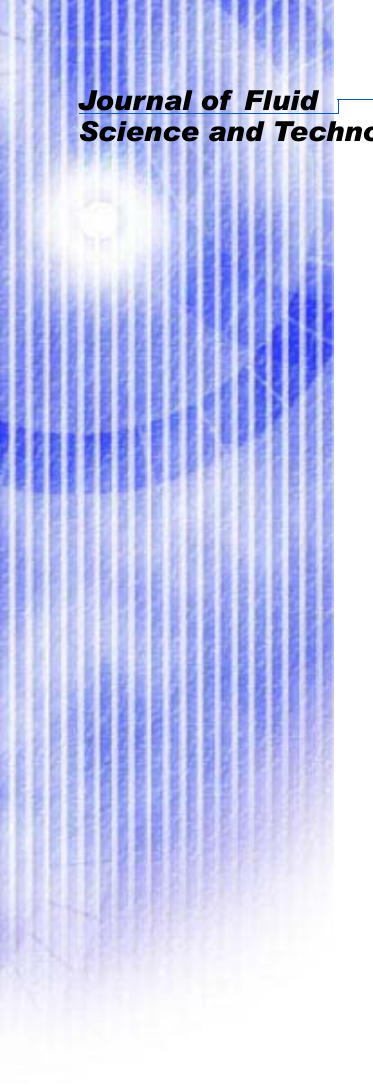
Fig. 5 Frequency response functions of the TLP ( L : D p : H p = 30 m: 6 m: 23 m; T 0 = 2290 kN). 4.2 Variation of tension in a tendon with the direction of forces Tension in a tendon varies with the direction of the external forces. Figure 6 shows the tension variation for tendon No. 1 against wind direction with the other forces in various combinations (Table 2). For all cases listed in Table 2, the maximum tension occurs at θ = –90°, whereas the minimum occurs at θ = +90°. As the values of the other tendons are identical to this in point symmetry with an angle of ± 120°, the following studies are represented by tendon No. 1.